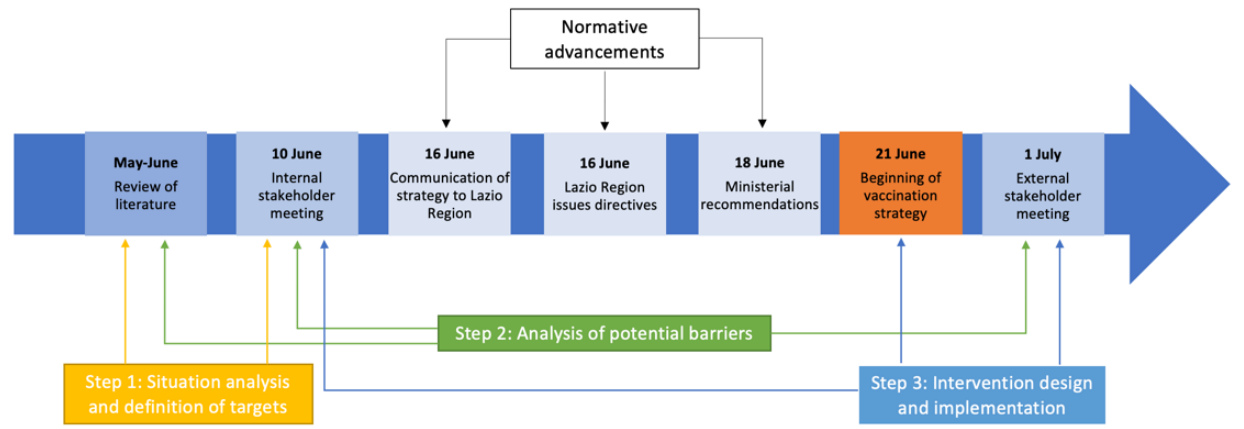
Figure 1. Timeline of the development of the vaccination strategy for socially vulnerable categories.